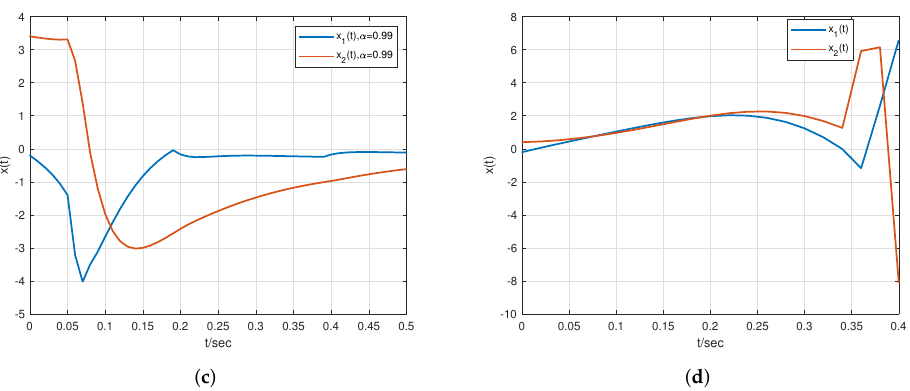
Figure 4. The panels ( a – c ) contain the curves of state variable x 1 ( t ) and x 2 ( t ) for passivity execution with distinct FO circumstances α = 0.85,0.9,0.99. Moreover, panel ( d ) is the trajectories of the open loop system in Example 1.